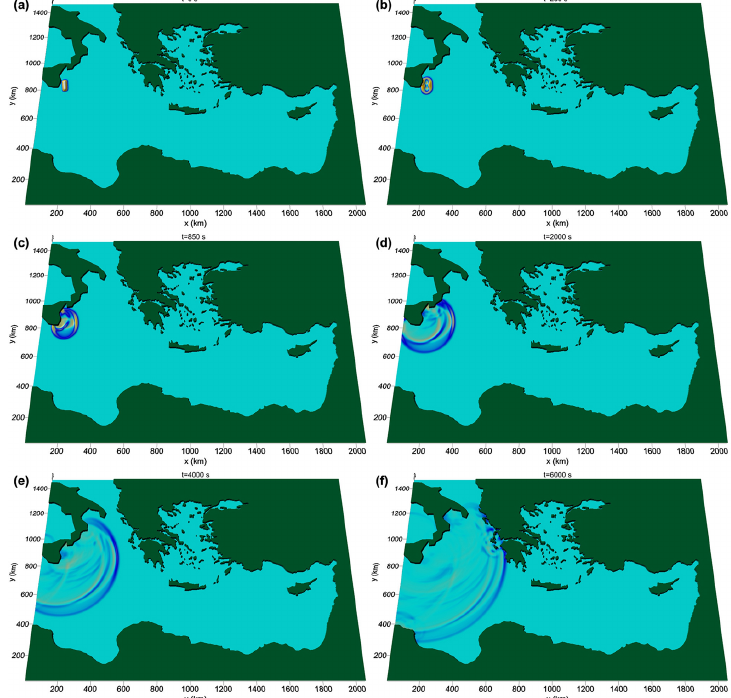
Figure 9. Sequences of snapshots of water elevation for the earthquake-induced tsunami scenario at the East of Sicily at: (a) t = 0s (genera- tion), (b) t = 250s, (c) t = 850s, (d) t = 2000s, (e) t = 4000s, and (f) t =